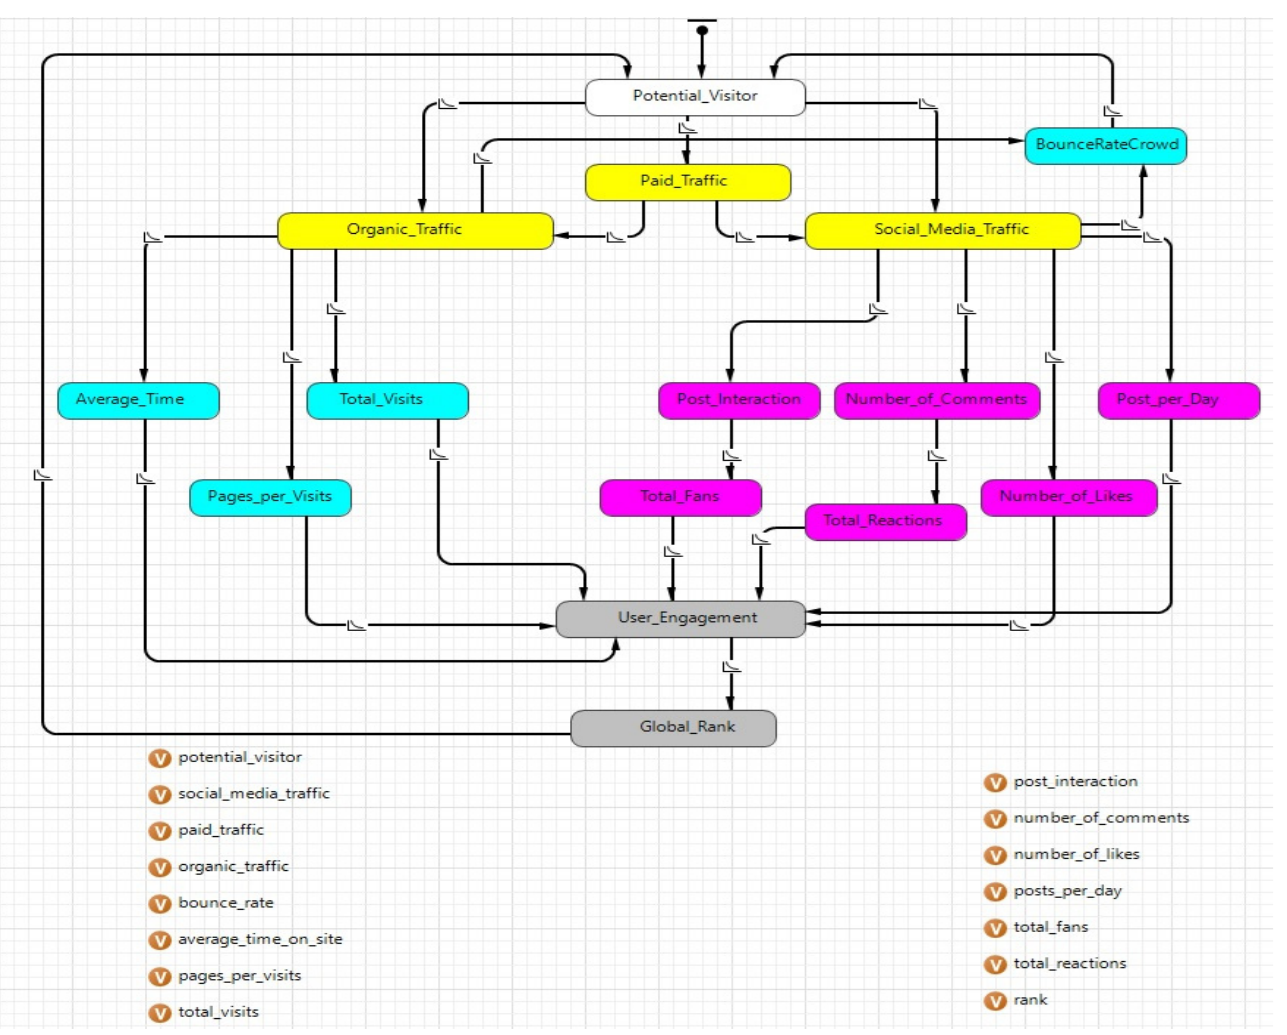
Figure 5. ABM. Figure 6 illustrates the predictive model population distribution over a six-month period. On the left-hand side of Figure 6a, the 20th dayof the model can be observed, and on the right-hand side of Figure 6b, the 170 days of the predictive model can be identified. The blue agents represent the website’s behavioral factors, the red represents the paid traffic, the light blue the social media factors, the yellow represents the organic traffic, and the gray represents the global ranking. As can be observed, on the right-hand side and after 170 days, the gray and yellow agents are more than the day 20, which illustrates the rise of website traffic and ranking, which leads to the rise of the digital brand name.